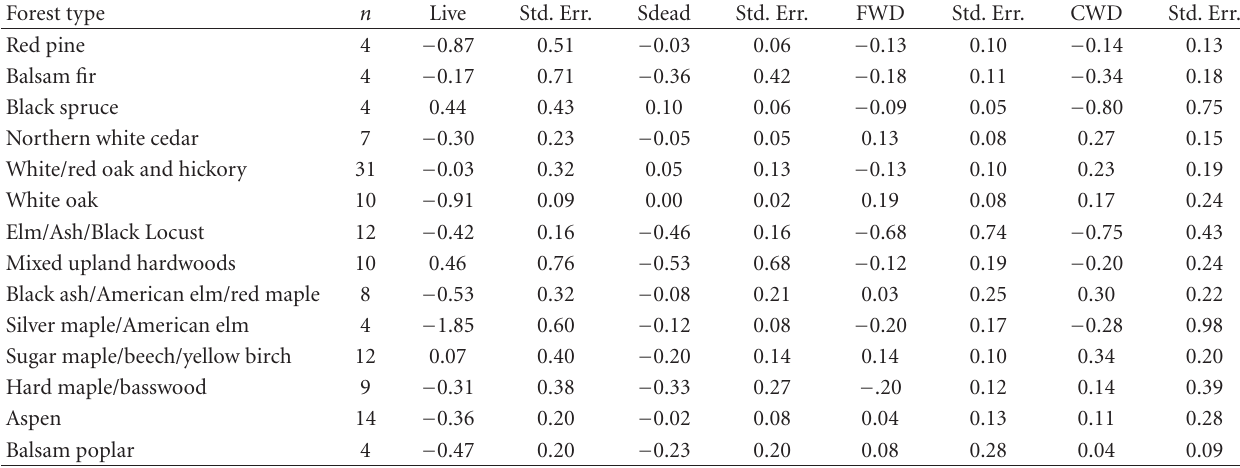
Table 2: Average annual carbon flux by forest type for down woody material components where n > 3: live (standing live trees), Sdead (standing dead trees), FWD (fine woody debris), and CWD (coarse woody debris) where a negative estimate indicates a net sequestration north central across the United States, 2002 to